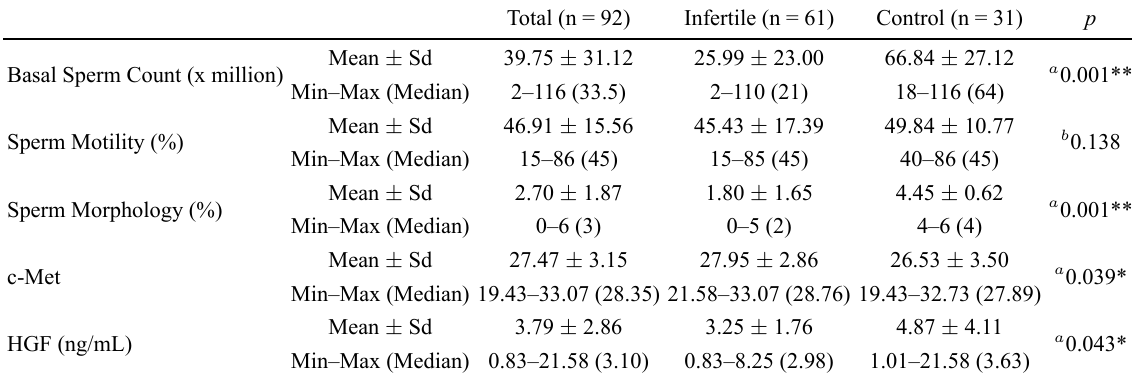
Table 2. Sperm count, sperm motility percentage, sperm morphology percentage, c-Met expression level, and HGF level in the total, infertile and control